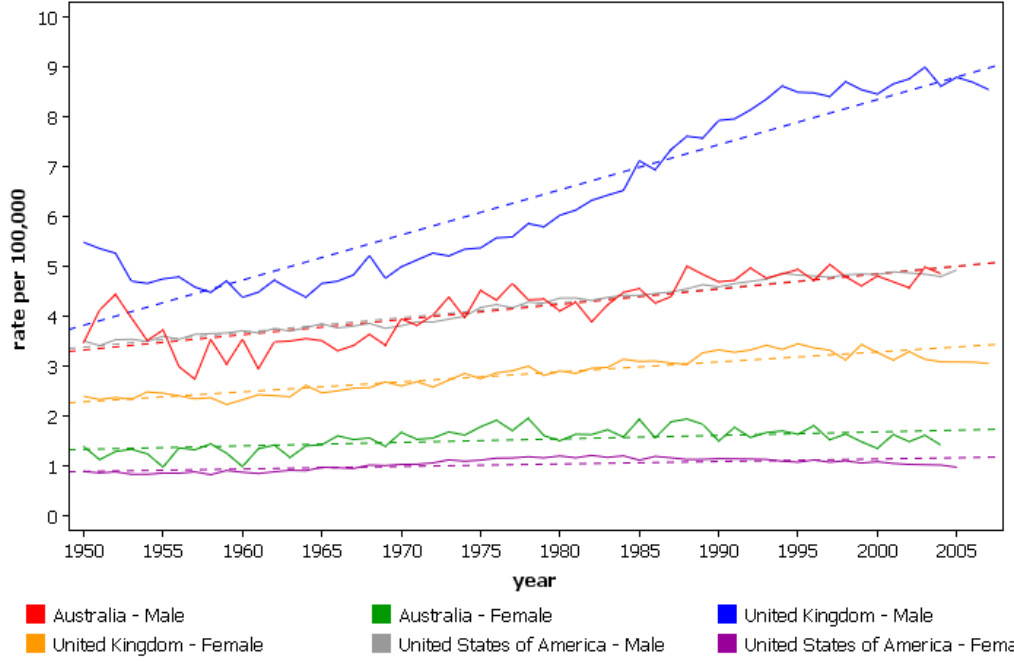
Figure 3. Mortality from esophageal cancer in westernized nations experiencing increased incidence, age-standardized rates (world). (From the WHO mortality database, International Agency for Research on